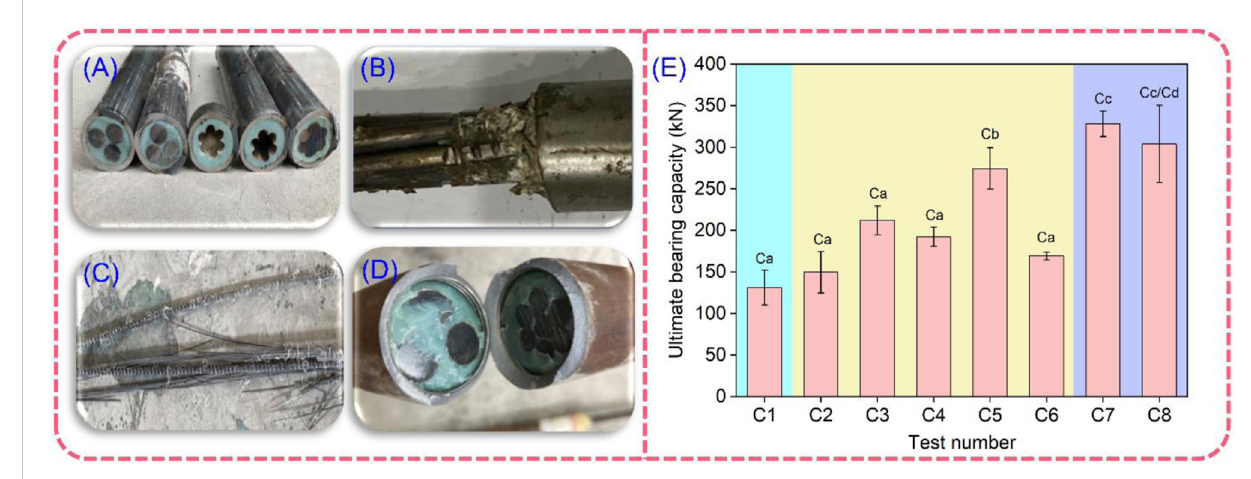
FIGURE 10 Failure modes of the SBCASs and UBC of SBCAS with different manufacturing parameters: (A) Slipping out of the steel strand (Ca), (B) Slip failure of the steel strand (Cb), (C) BFRP bar bursting (Cc), (D) Fracture of the coupler (Cd), (E) UBC test results of